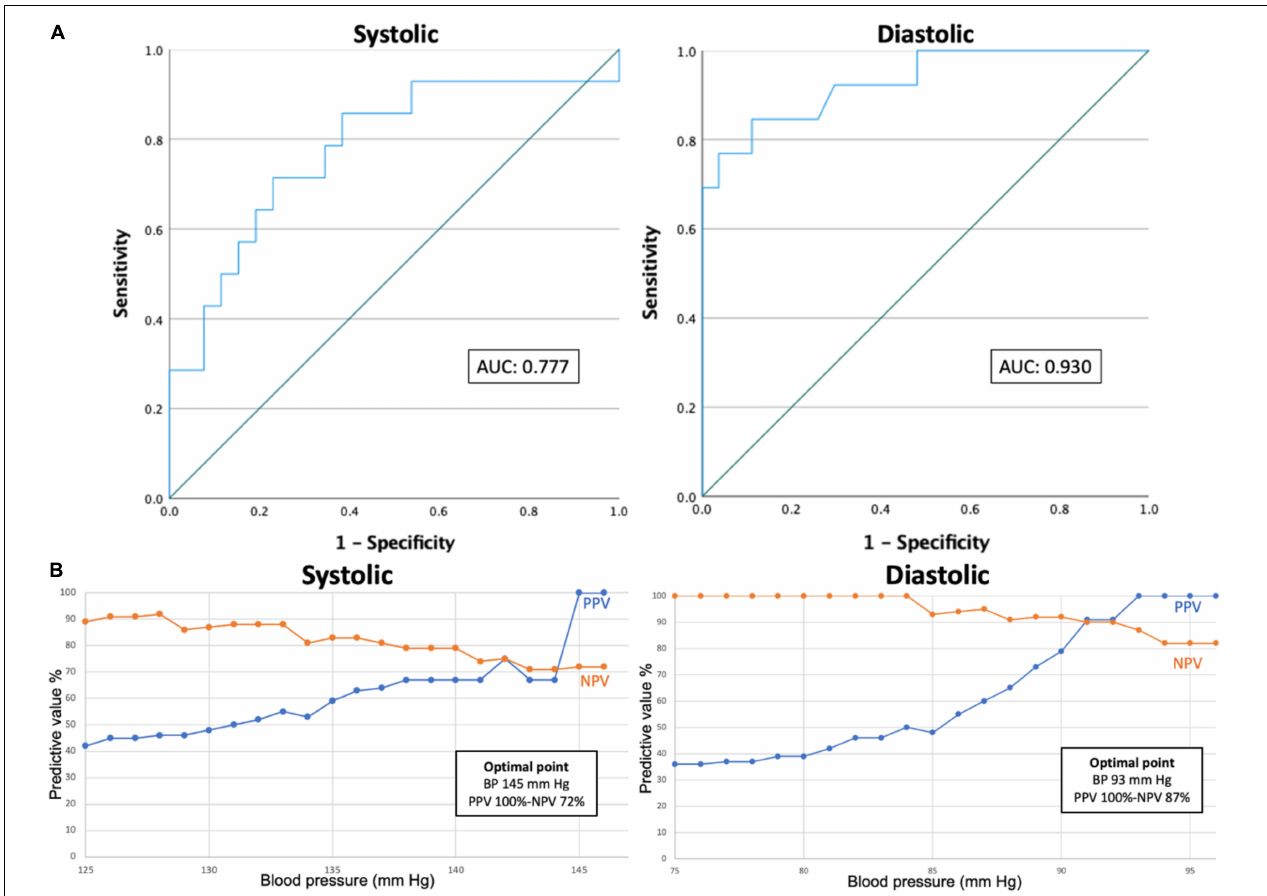
FIGURE 3 | ROC curves (A) and PPV/NPV optimization curves (B) . ROC curves and PPV and NPV optimization curves in predicting systolic (left) or diastolic (right) hypertension. AUC, area under the curve. BP, blood pressure. PPV, positive predictive value. NPV, negative predictive value. ROC, receiver operating characteristic.